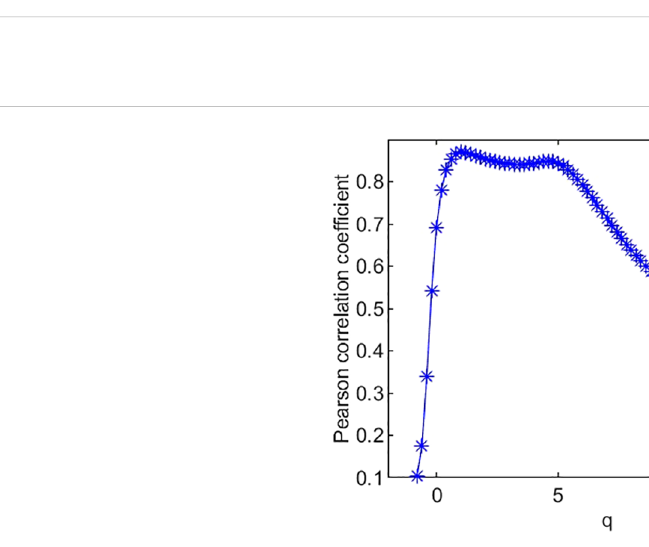
FIGURE 5 Pearson correlation coef fi cient of species ’ Shannon diversity index and multifractal dimension D ( q